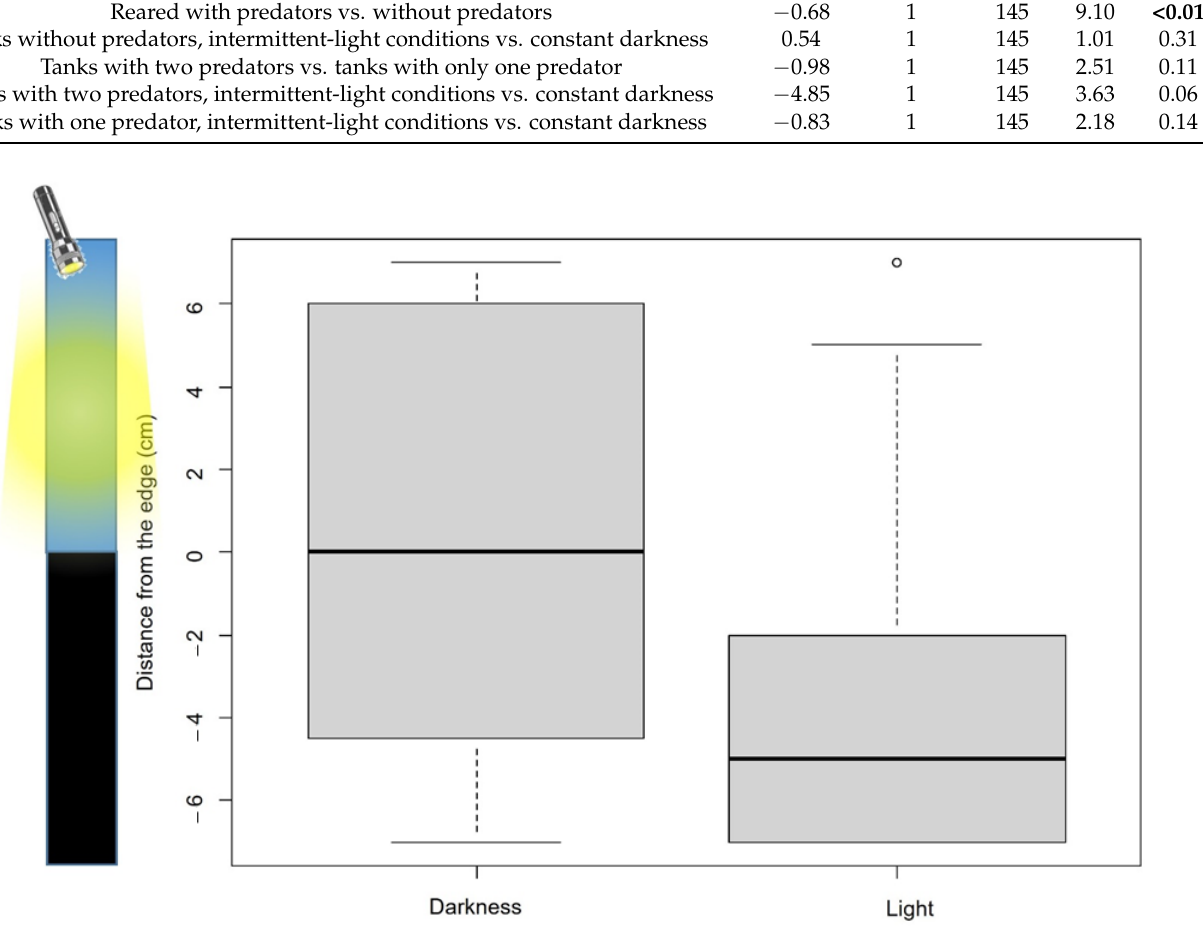
Figure 3. Box–whisker plot of the relationship between the distribution of N. thuringius in the presence or absence of a light source during the behavioral tests. Values of the disposition of individuals are assessed in relation to the center of the arena corresponding to 0. Negative values indicate an arrangement towards the covered half of the arena, whereas positive values indicate an arrangement towards the uncovered half of the arena.